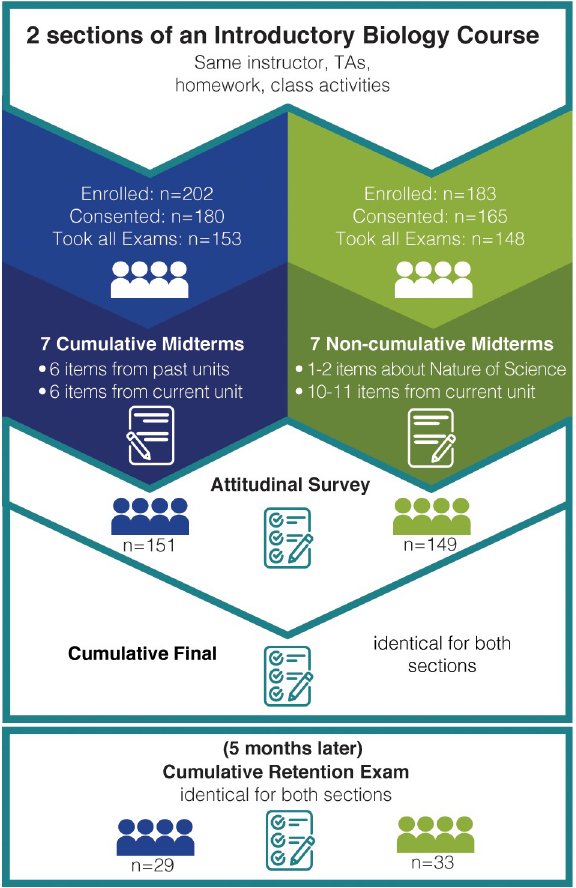
Fig 1. Quasi-experimental study design. Blue represents the cumulative section, and green represents the non- cumulative section.